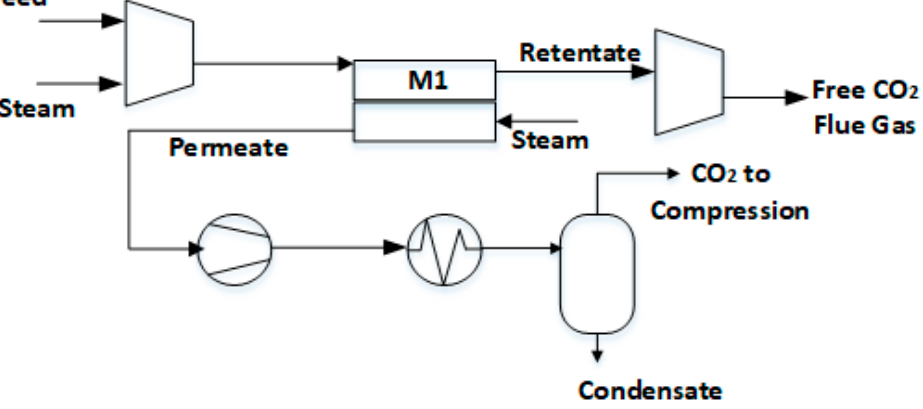
Figure 2. Simplified PFD of FTM technology for carbon capture considered in the